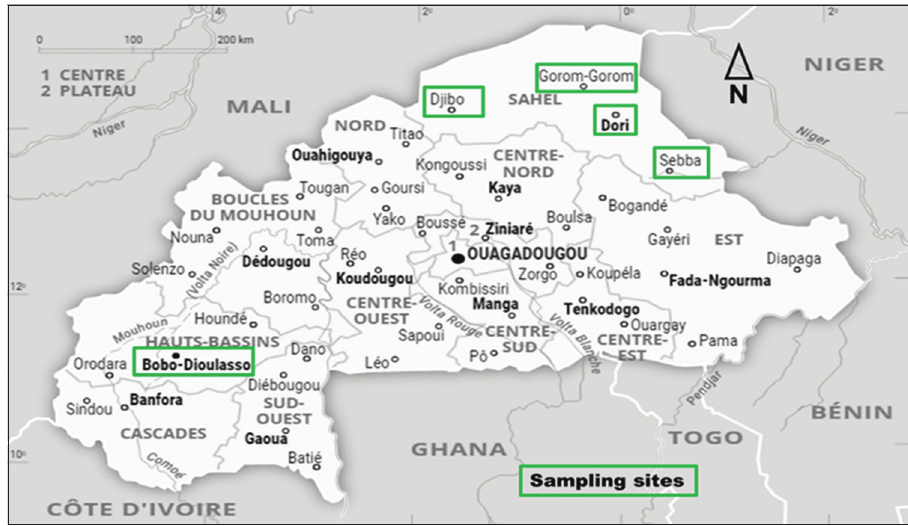
Figure-1: Localities of collected samples (Source: